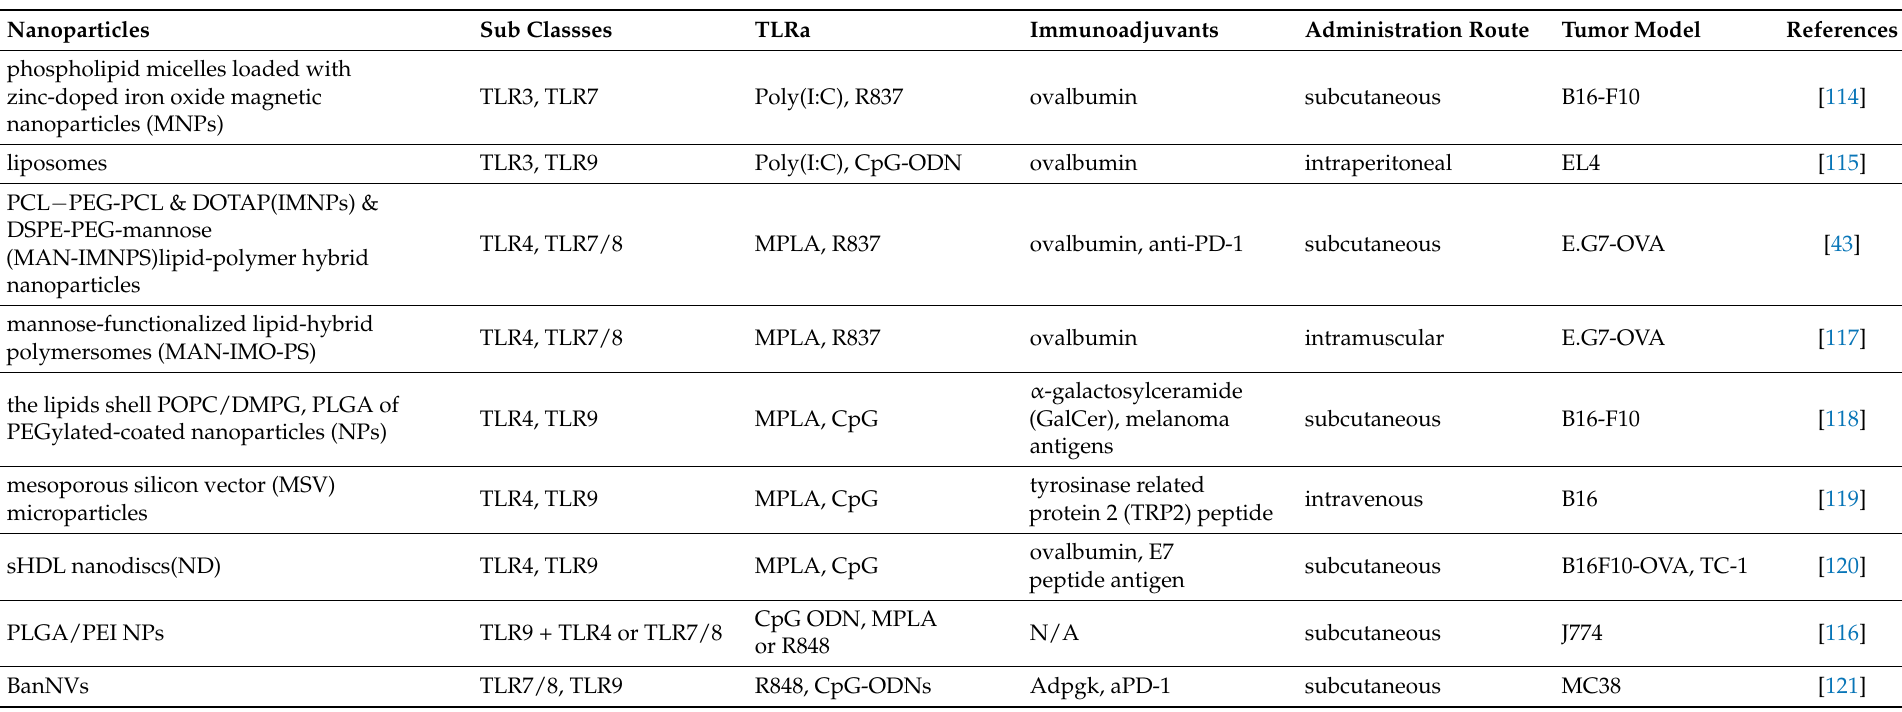
Table 2. Multiply TLRa in combination with